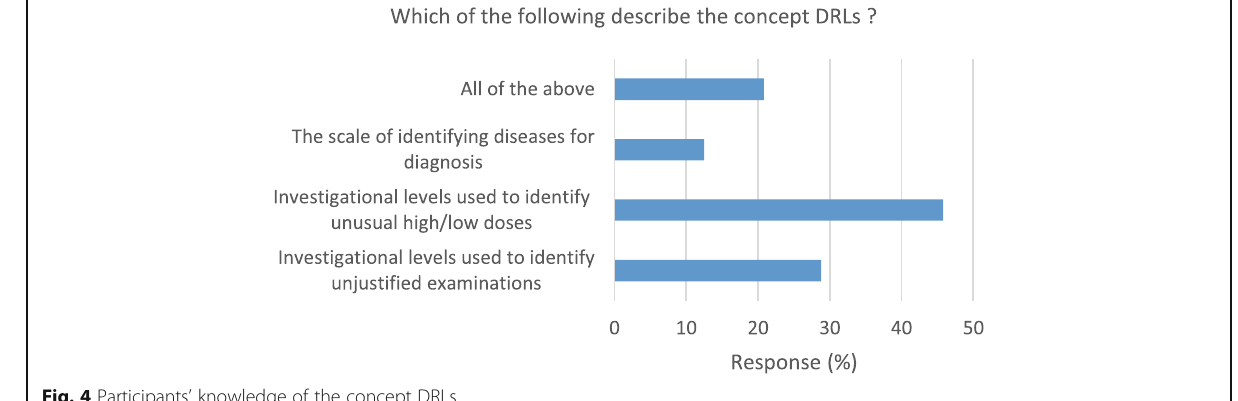
Fig. 4 Participants ’ knowledge of the concept